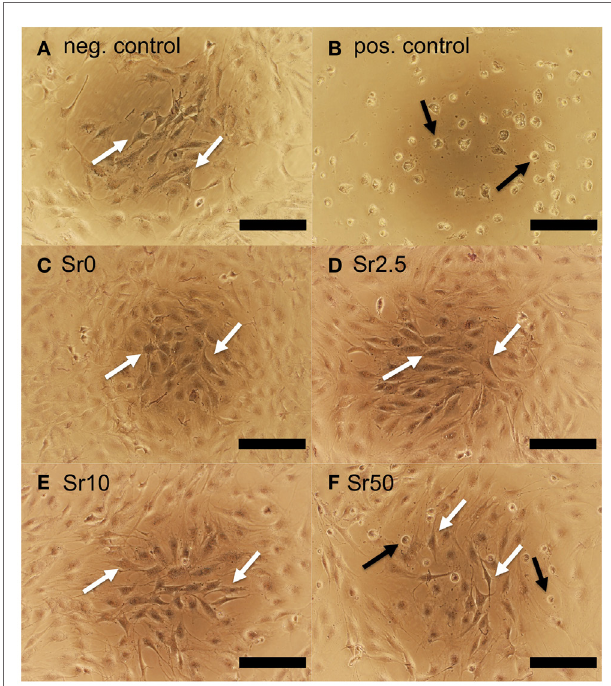
FigUre 6 | Mc3T3-e1 cells cultured for 24 h in conditioned medium soaked with (a) negative and (B) positive control and (c–F) cements prepared with glasses sr0 to sr50 . Examples of cells with normal morphologies are indicated with white arrows; cells with poorly spread morphologies are indicated with black arrows (scale bar is 200 μ m).